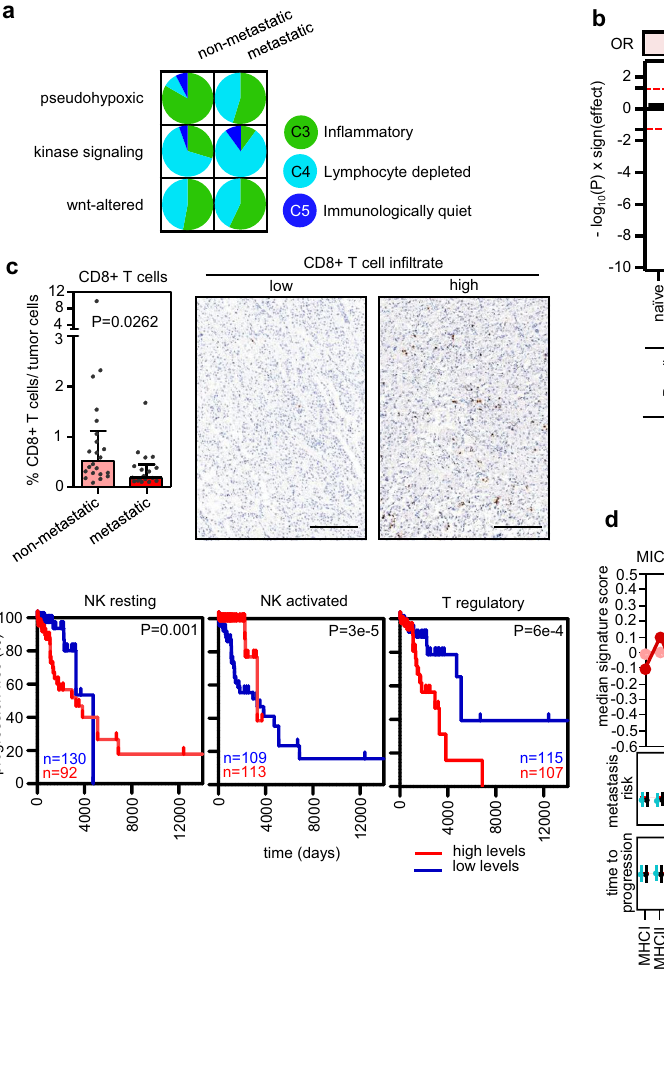
metastatic and non-metastatic primary tumors. Two-sided MWW was applied to test for differences between metastatic ( n =55) and non-metastatic ( n =176) pri- mary tumors; signi fi cant P values are shown. Univariate (black) and multivariate (blue)logisticandCoxregressionanalysisofmetastasisrisk(middlepanel)andTTP (bottom panel), respectively. Enrichment scores were used as a continuous vari- able. Multivariate analysis included genomic subtype as covariate. Only data from primary tumors from non-metastatic and metastatic patients were included. Sig- ni fi cant associations in Fges scores after multivariate analysis are shaded in blue. e Kaplan – Meier plots of time to progression in patients according to different immune cell type levels found in primary tumors. Only primary tumors from non- metastaticandmetastaticpatientsincluded.Highlevels(abovethemedianlevelof thewholegroup)arerepresentedinred( n =92, n =113,and n =107,respectivelyfor NK resting, NK activated and T regulatory) and low expression (below the median level) in blue ( n =130, n =109 and n =115, respectively for NK resting, NK activated and T regulatory). P -valuesshown insidethe plots were calculated using a log-rank test. Patients without evidence of metastases were censored at the date of the last follow-up. See Supplementary Fig. 10 for the extended version. Source data are provided as a Source Data fi le.